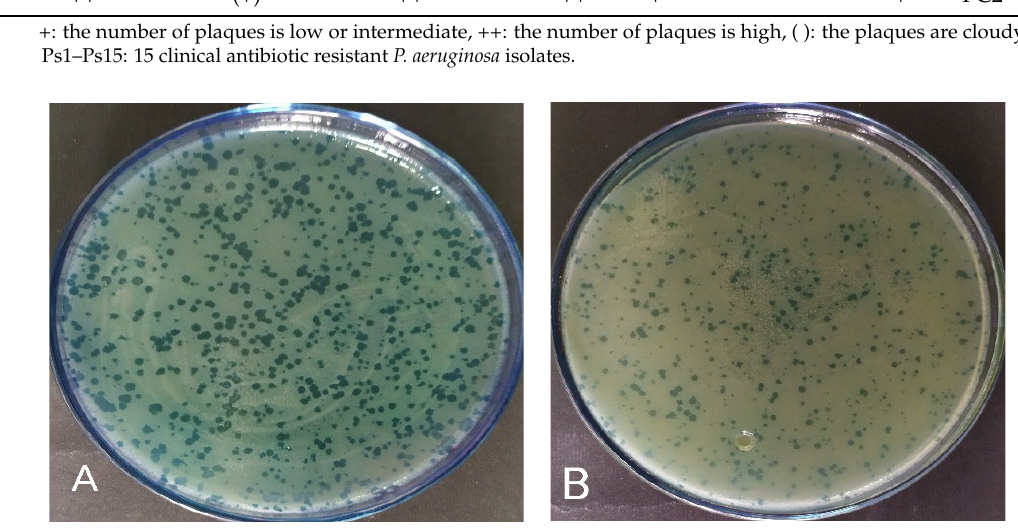
Figure 2. Morphology of phage particles under transmission electron microscope. Phage PB10 ( A ) and PA19 ( B ). The scale bars represent 100 nm . 3.3. Phage Genome Characterization The sequences of the genomic DNA of phages PB10 and PA19 were determined using the Illumina paired-end technology. The assembled genomes were 66,096 and 65,660 bp in size, respectively. PhageTerm analysis predicted that both phages use headful packag- ing starting from a pac site. Comparison of the genomes demonstrated that the phages were closely related to each other with 86% identical collinear genomes (Figure 3A). Com- parison of the genomes to known phages revealed that they are >90% identical to a grow- ing group of PB1 - like Pseudomonas phages belonging taxonomically to the genus Pbuna- virus of the Caudoviricetes class [35,36]. Comparison of the putative receptor-binding protein sequences encoded by the gene g62 of both phages revealed distinct differences in the C -terminal third of the proteins (Figure 3B) , which can explain the host range differences between the phages (Table 1).